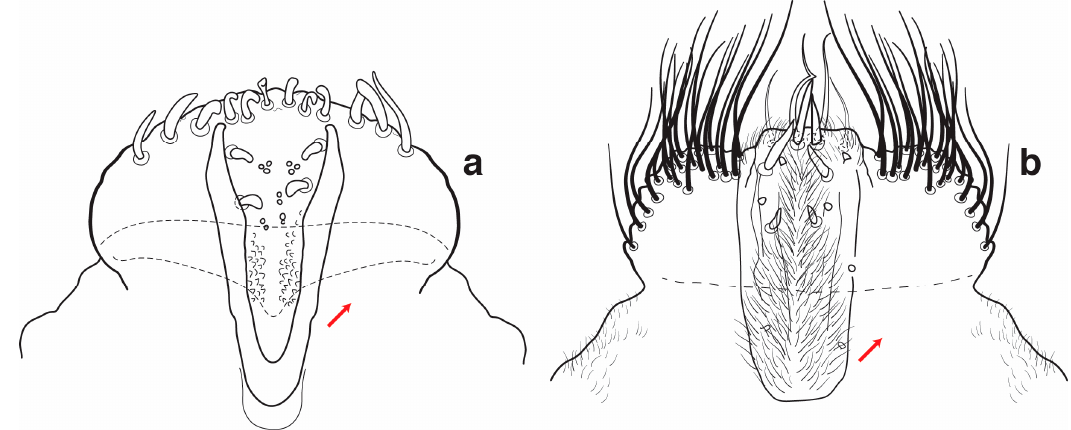
Figure 18. Epipharynx, larva: ( a ) Myocalandra ; and ( b ) Cyrtotrachelus.